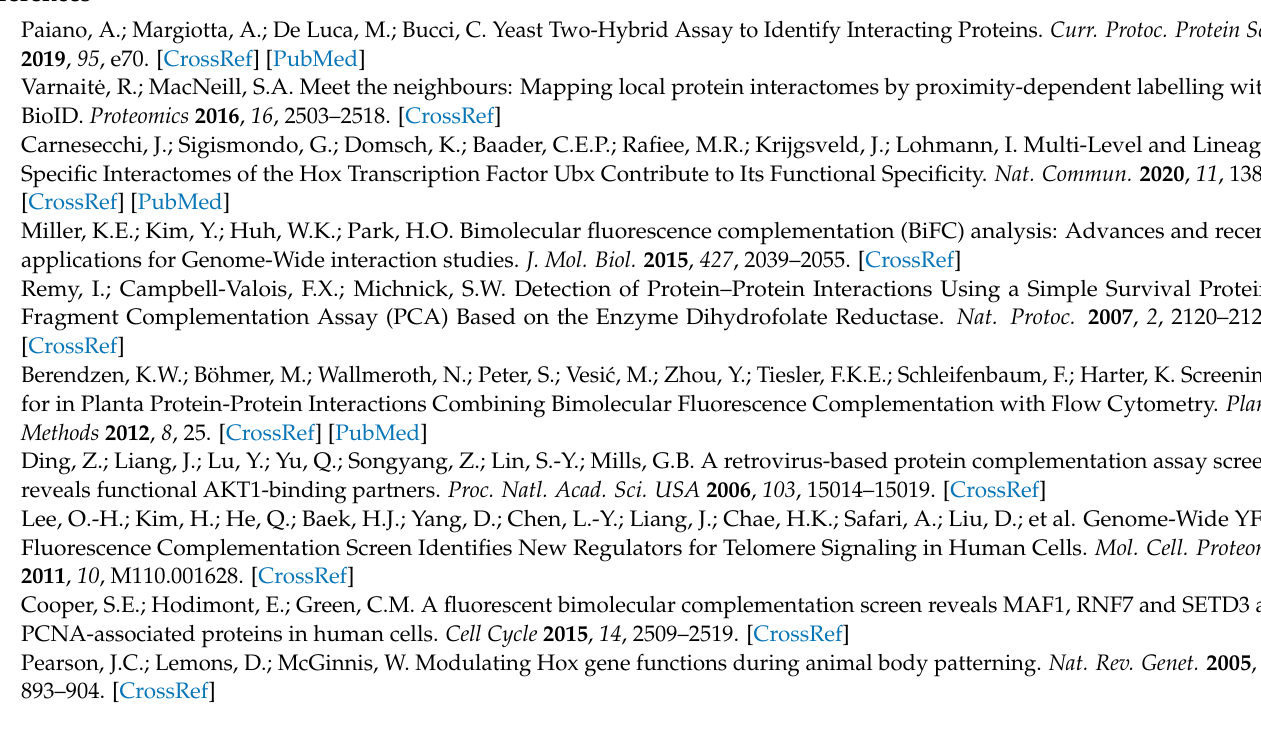
2; Table S5: List of HOXA9-interacting proteins identified by Cell-PCA screening; Table S6: List of HOXA9W-interacting proteins identified by Cell-PCA screening; Table S7: Full list of HOX-interacting proteins identified by Cell-PCA screens; Table S8: hORFs identified with the first 50bp (with up to 3 bp differences) upon BLASTN with the hORFeome